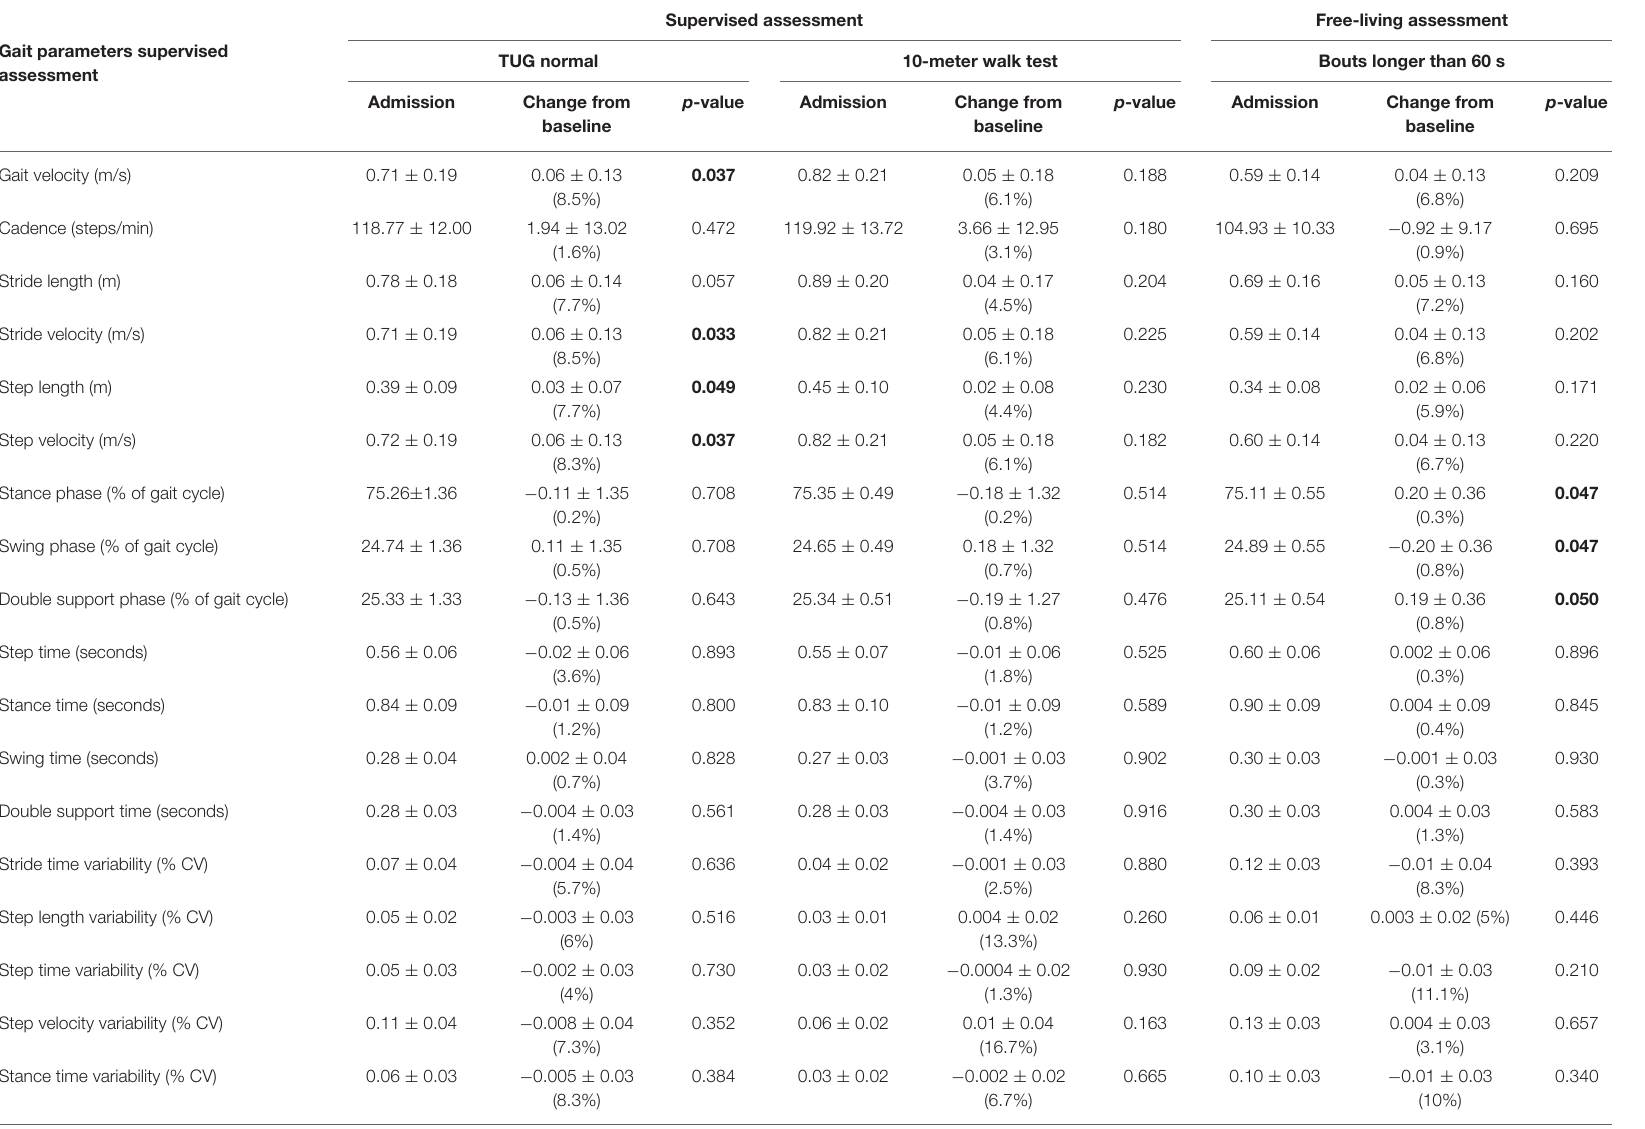
TABLE 2 | Admission (i.e., baseline) and change from baseline values (i.e., mean post-pre assessment difference and respective percentage value) of gait parameters in the supervised and free-living assessments.